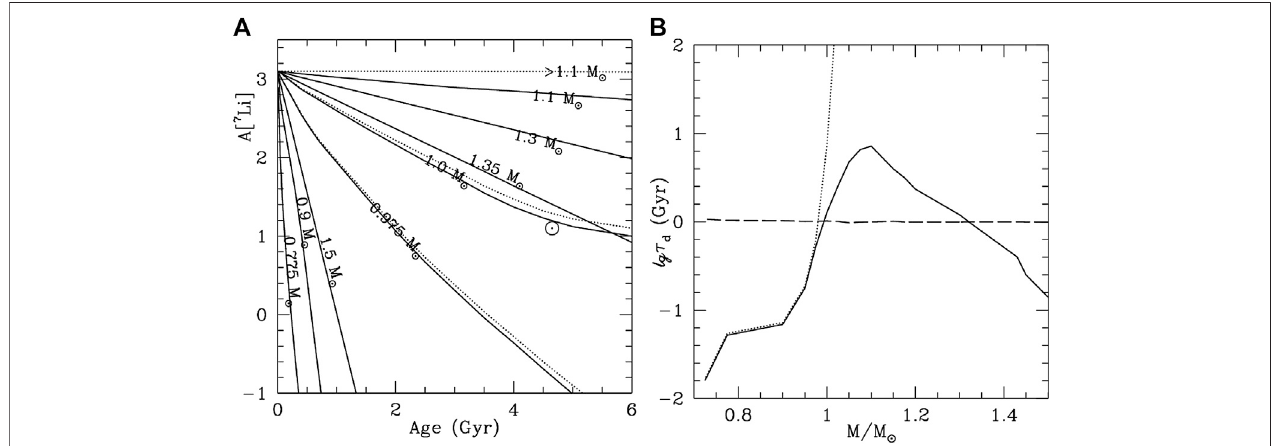
FIGURE 9 | (A) Evolution of the surface lithium abundance with age for stars of different masses. The dotted and solid lines, respectively, are for models with only convective overshooting mixing, and for which both gravitational settling and convective overshooting mixing are taken into account. (B) The e-folding time of lithium depletion as a function of stellar mass. The dotted lines are the models for which only the overshooting mixing are taken into account; the solid lines are models in which both overshooting mixing and gravitational setting are taken into account.